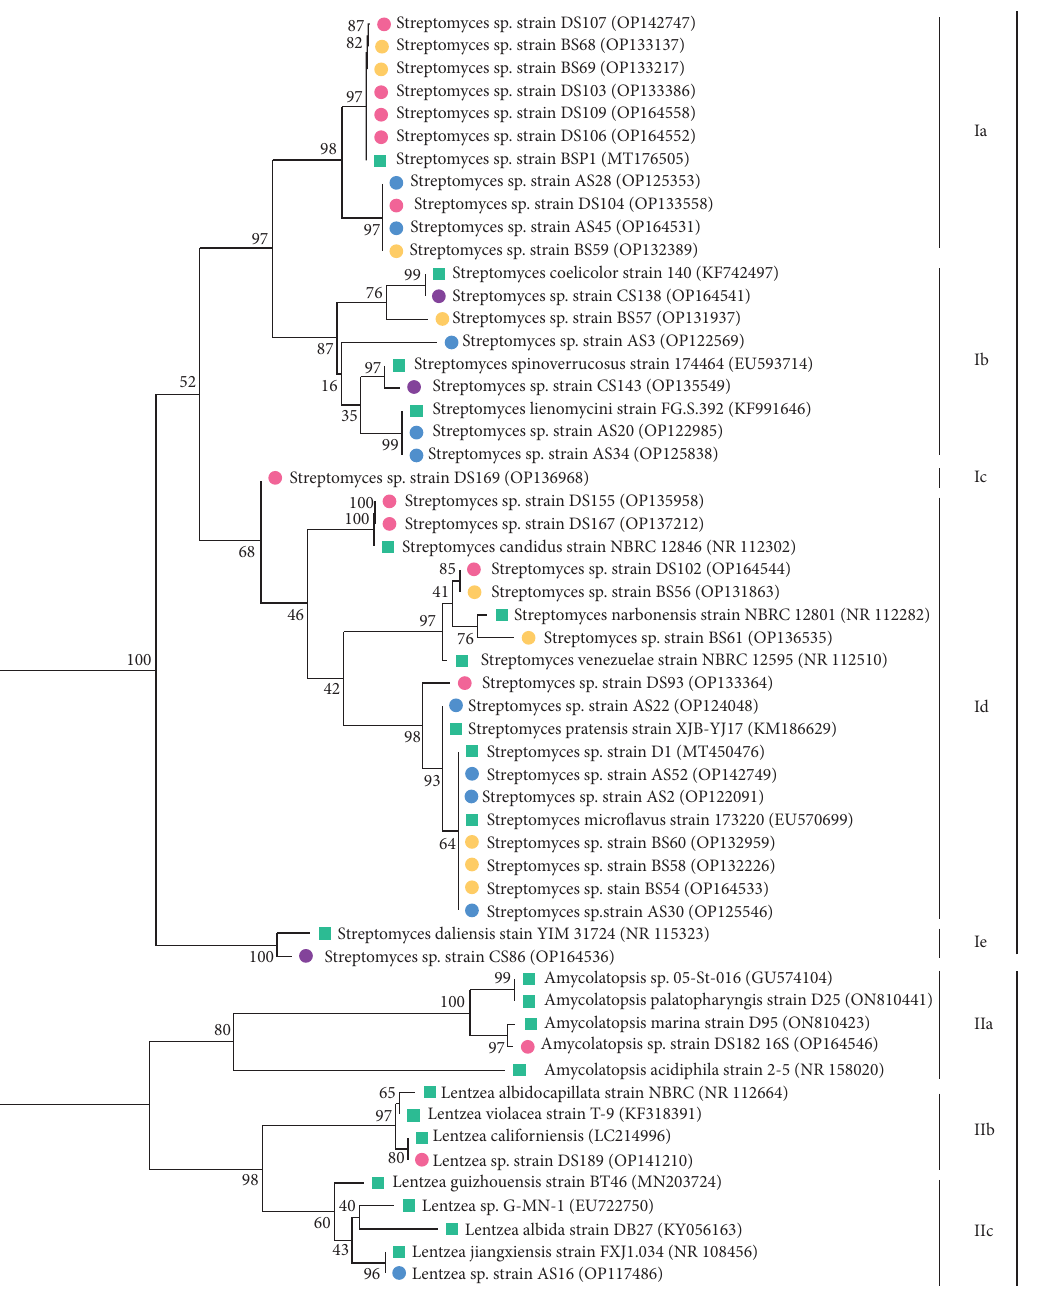
Figure 5: Neighbor-joining phylogenetic tree based on 16S rRNA gene sequences of selected strains (antagonistic strains with high antimicrobial activity and other inactive strains). Blue, orange, purple, and pink circles represent strains from, respectively, Ahouli, Mibladen, Midelt, and Zaida sites. Red square represents GenBank closest type species. Number at branches designates bootstrap values of neighbor-joining method from 1000 replicates and the bar designates 1% sequence divergence. I and II: clades I and II; Ia, Ib, Ic, Id, and Ie: subclades Ia, Ib, Ic, Id and Ie; IIa, IIb, and IIc: subclades IIa, IIb, and IIc. Te evolutionary distances were calculated using the maximum composite likelihood method, and the analysis was conducted in MEGA11 [31,